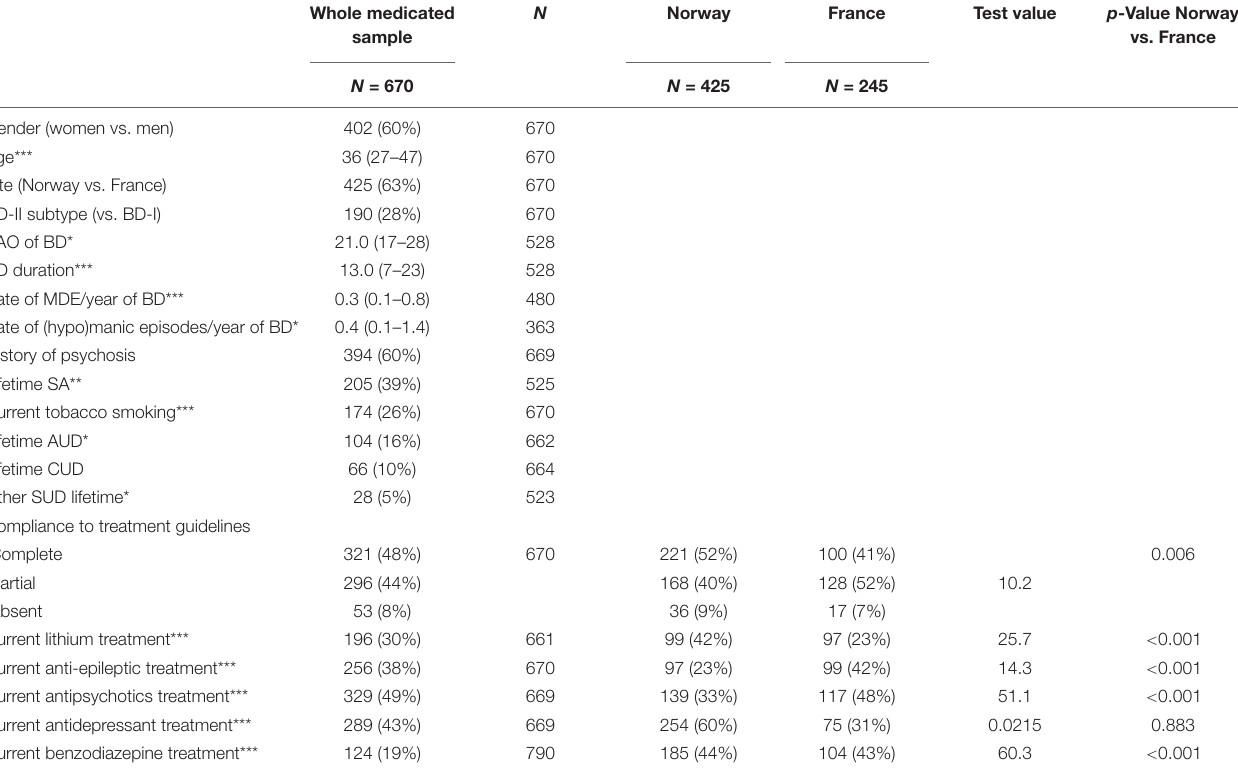
TABLE 1 | Description of the medicated sample, as a whole, and by country. Whole medicated N Norway France Test value sample